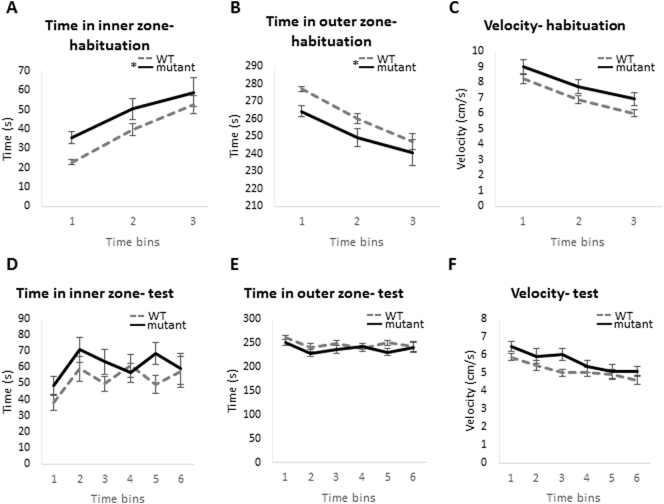
Comparison of wild-type and Zdhhc9 mutant mice in the open field test. Time spent by WT and mutant mice in the outer and inner sections of the test and their velocity during this time. (A–C) displays these parameters during the habituation phase of the test; (D–F) displays these parameters during the test time (n = 14 mutant, 20 WT). Statistics were conducted using general linear model, repeated measures in SPSS version 22 with time bin as the within-subjects factor and genotype as the between-subjects factor; F(1,32) = 4.646, p = .039 for effect of genotype in time spent in inner and outer zones and F(1,32) = 3.44, p = .073 for effect of genotype on velocity during habituation. Moreover, F(2,64) = 32.573, p < .001 for effect of time bin on time spent in inner and outer zones during habituation. There was no interaction between time bin and genotype for the time spent in inner and outer zones, F(2,64) = 0.482, p = .482. During test time, p = ns (non-significant) for effect of genotype on time spent in inner and outer zones and velocity. Each time bin represents a period of 5 min.